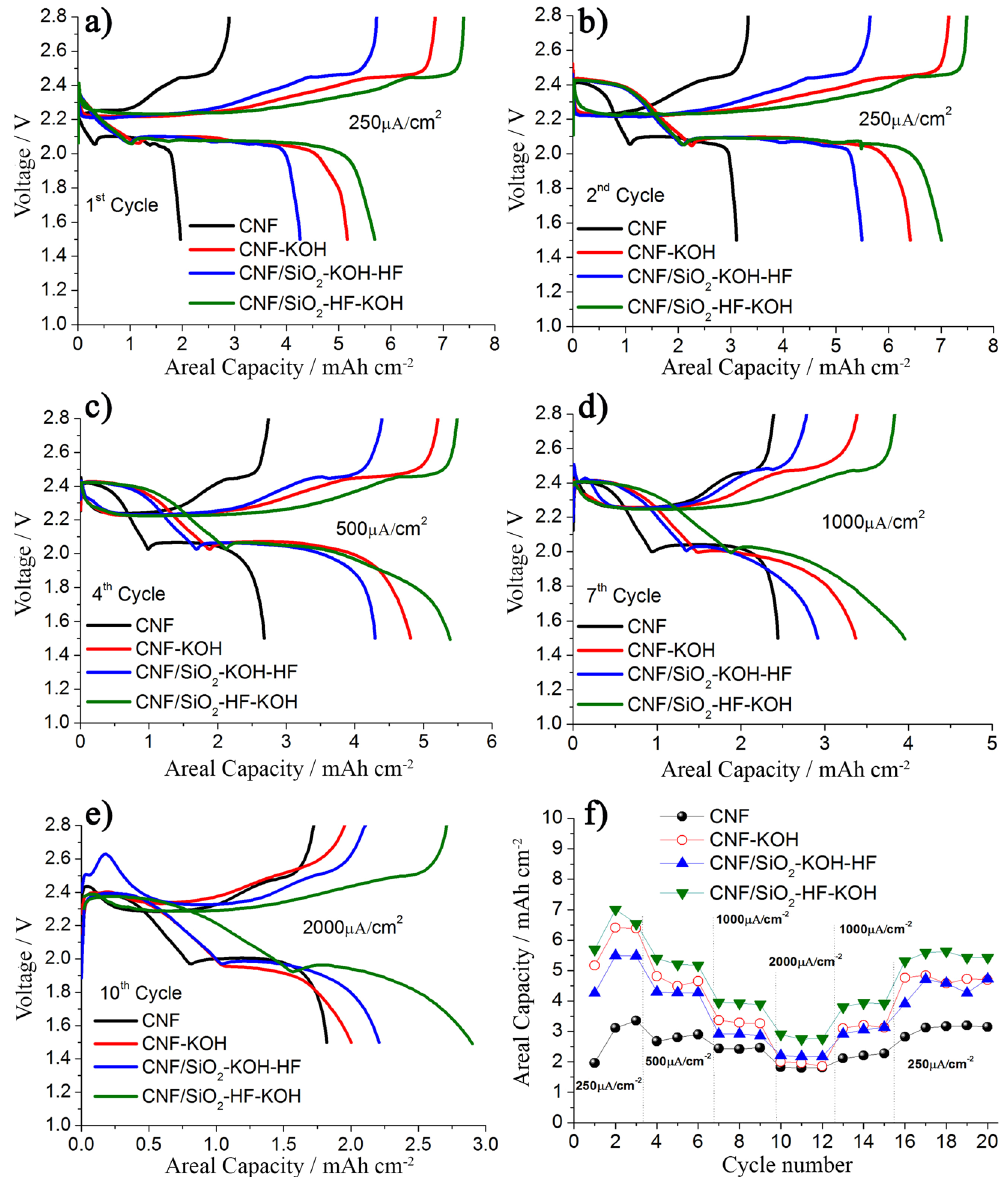
500 μ A cm − 2 , ( d ) 7 th cycle at 1000 μ A cm − 2 and ( e ) 10 th cycle at 2000 μ A cm − 2 . ( f ) Discharge areal capacity at the various current